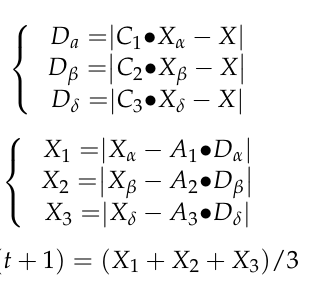
Figure 2. Prey tracing map.